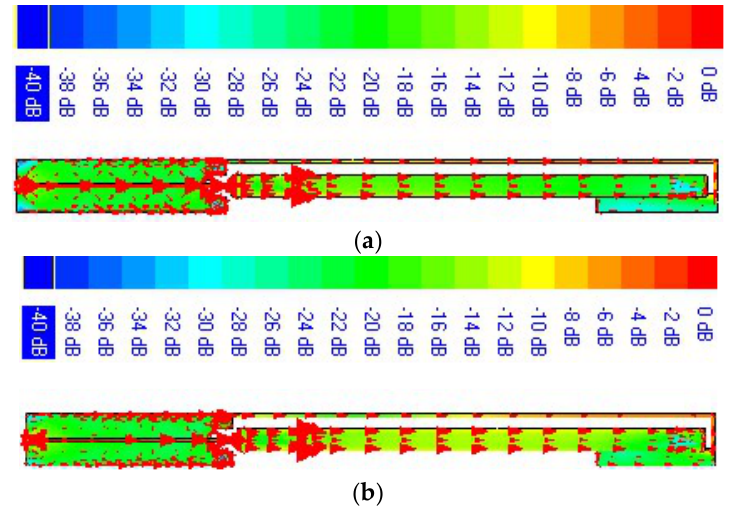
Figure 3. Current distributions at ( a ) 1.67 and ( b ) 2.08 GHz.